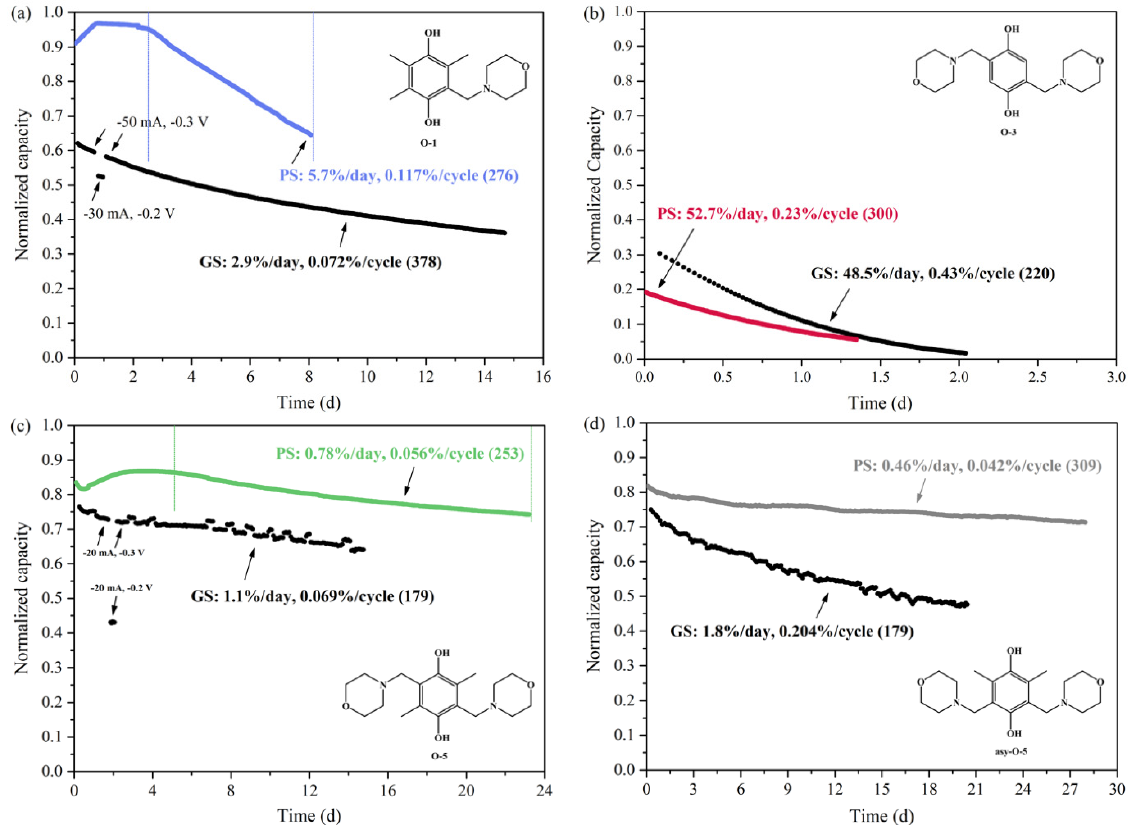
Figure 11. ( a – d ) Normalized discharge capacity of the symmetric cell tests of various modified benzoquinones using potentiostatic (PS) and galvanostatic (GS) cycling methods. Adopted from Molecules 2021, 26(13), 3823